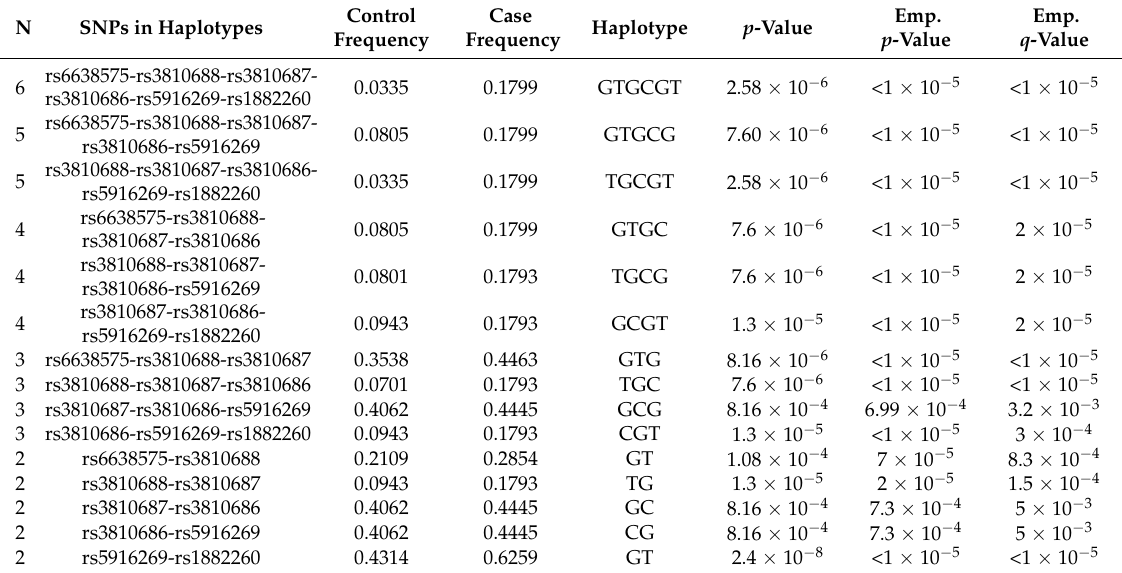
Table 2. Haplotype association analysis in NLGN4X ( EUR control population